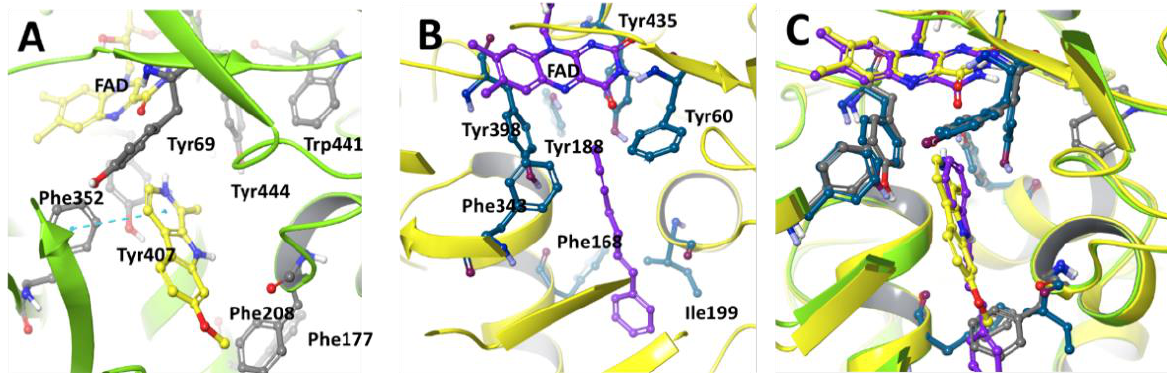
Figure 2. Active site configuration of human ( A ) MAO-A (PDB structure 2Z5X) with harmine and ( B ) MAO-B (PDB structure 1OJ9) with 1,4,-diphenyl butene, depicting key amino acids lining the enzyme active site. ( C ) Overlaid view of MAO-A and MAO-B substrate binding site. Harmine and 1,4,-diphenyl butene are selective reversible inhibitors of MAO-A and MAO-B, respectively.